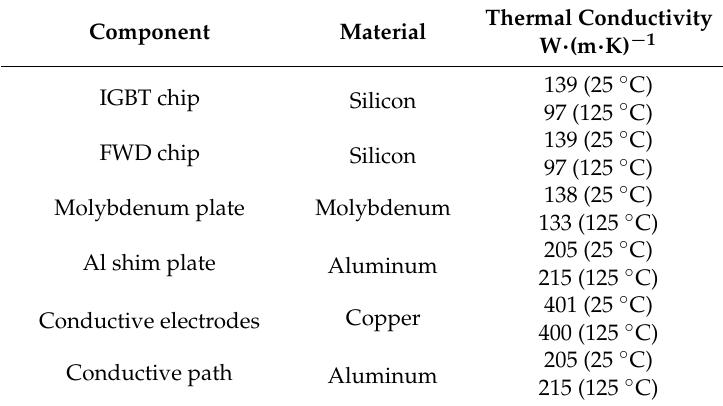
Table 1. Thermal conductivity of materials inside IGBT module.